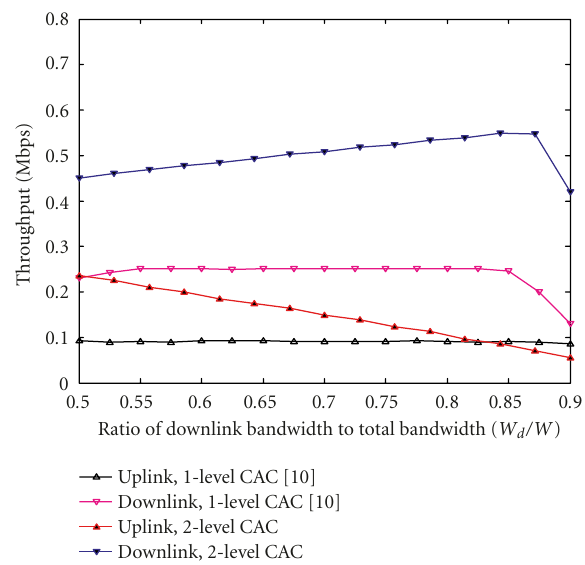
Figure 8: Average throughput versus downlink bandwidth ratio, W d